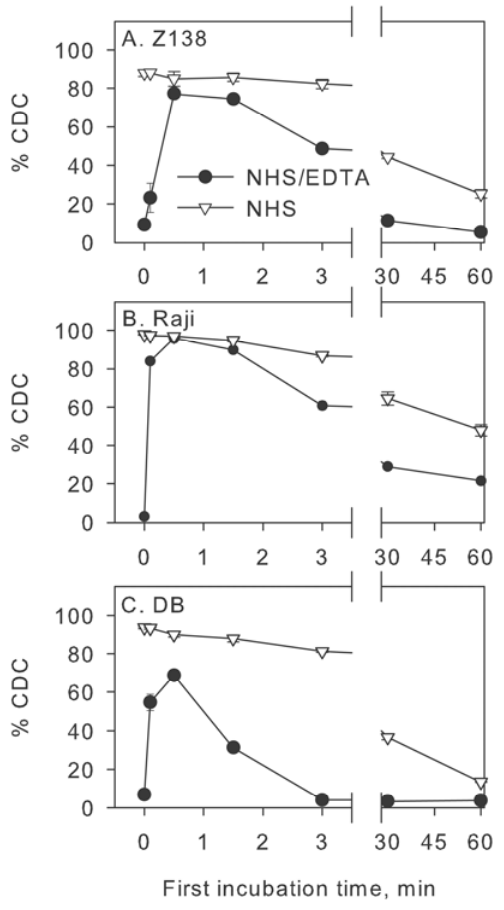
Figure 2. Extended incubation with C5-depleted serum reduces the ability of intact NHS to kill cells: Comparison of NHS/EDTA with NHS in the second incubation. Cells ( A . Z138, B . Raji or C . DB) opsonized with 10 µg/mL OFA were first incubated with 50% C5-depleted serum as in Figure 1A. The second incubation was carried out for 30 min in either 50% NHS supplemented with 10 mM EDTA (filled circles) or in 50% NHS (open triangles). At longer first incubation times, there was less killing of cells, even if intact NHS was used in the second incubation